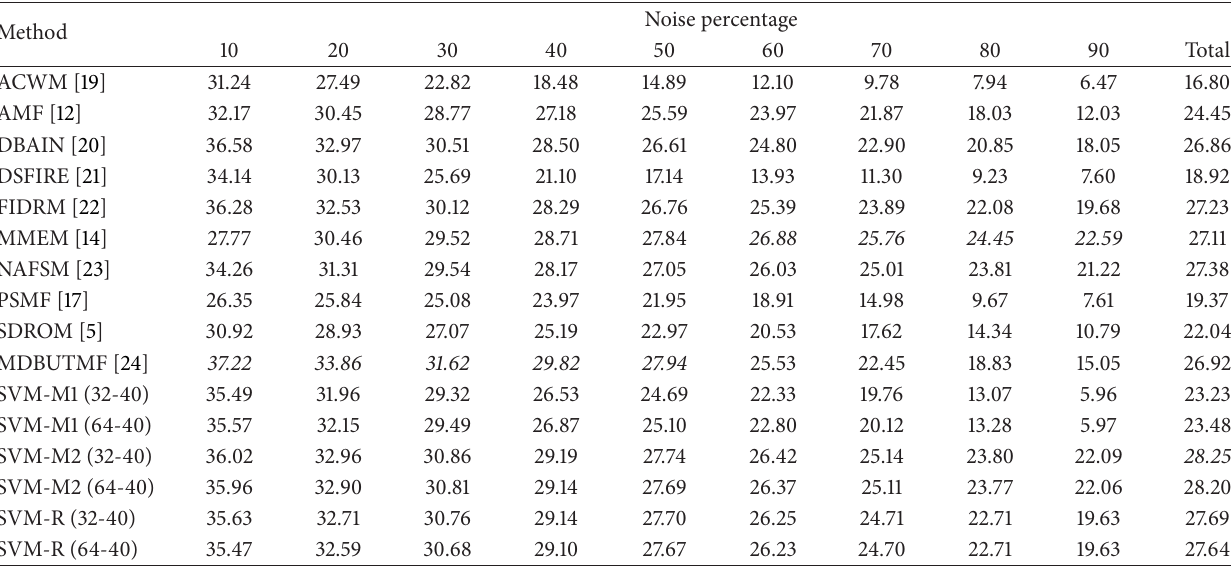
Table 3: Table results in mean PSNR for different impulse noise reduction methods. The mean is obtained for different noise ratios in 10 test images. Total column reflects the total mean for all ratios and images.